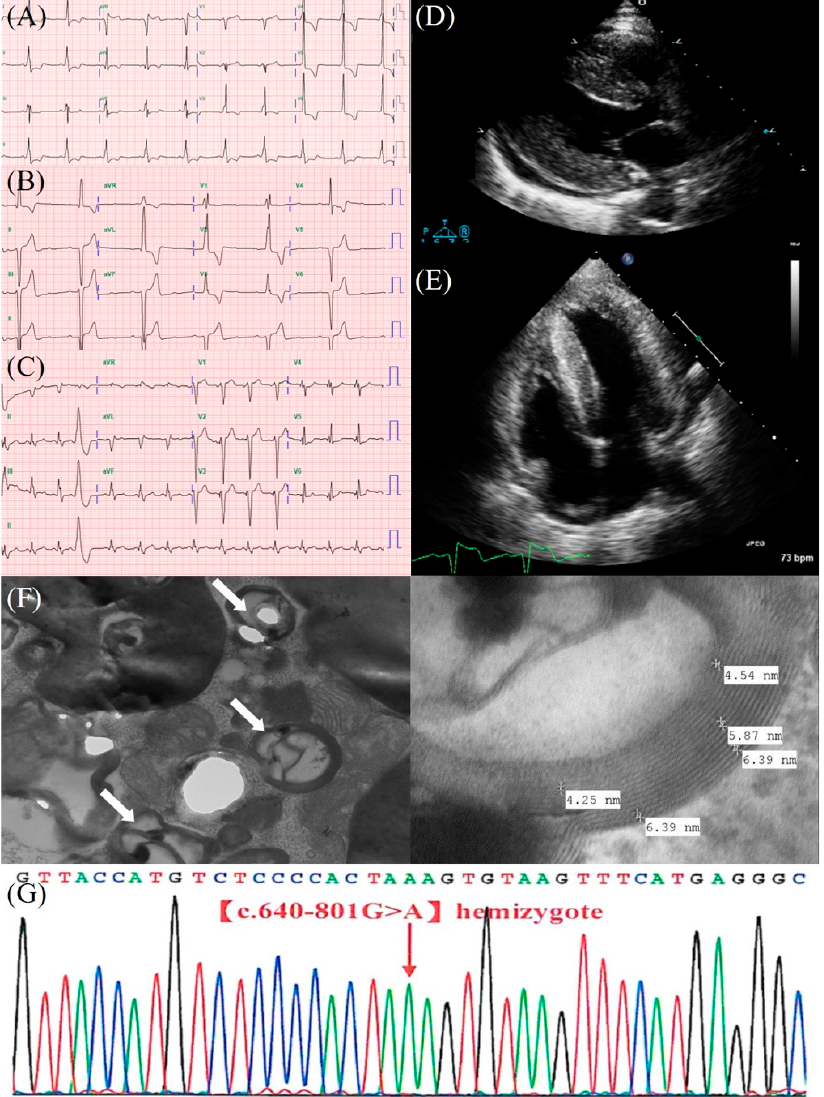
Figure 1. ( A ) The initial 12-lead ECG showed short PR-interval and LVH pattern. ( B ) The 12-lead ECG showed sinus rhythm with 3:1 AV block. ( C ) The 12-lead ECG showed biventricular pacing rhythm. ( D , E ) The initial TTE for the patient showed the generalized LVH pattern (( D ): parasternal long axis view and ( E ): apical four chamber view). ( F ) The pathology showed the typical features of FD on electron microscopy (arrows indicate zebra bodies, with a periodicity of 5–6 nm in the cardiomyocytes). ( G ) The genetic study shows c.640-801G>A polymorphism (cardiac variants of FD).